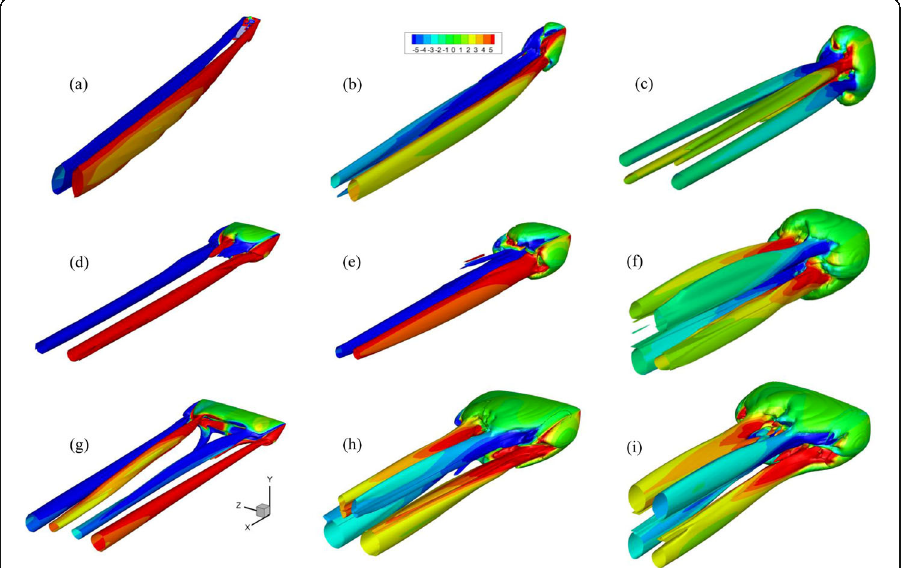
Fig. 8 Iso-surface of λ 2 colored by streamwise vorticity at a ) α = 30°, AR = 0.5, b ) α = 60°, AR = 0.5, c ) α = 90°, = 90°, AR =